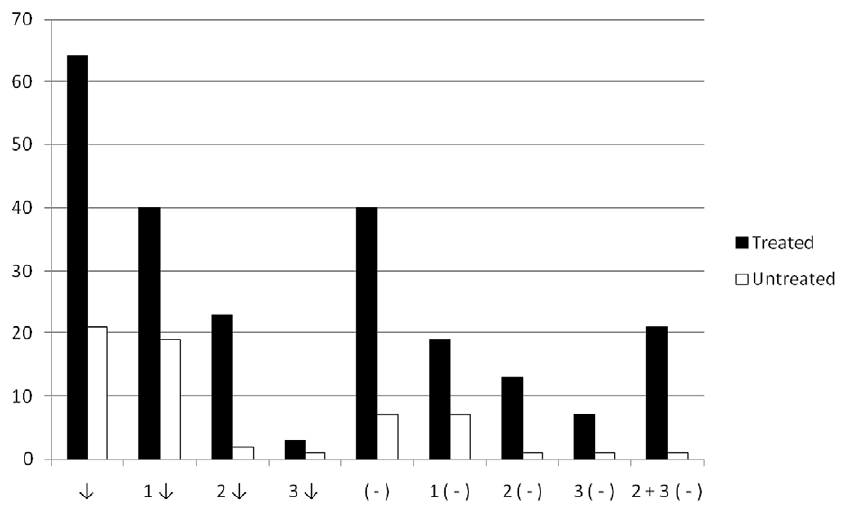
Figure 1. Percentages of titers decrease and seronegative conversion in treated and untreated chronically T. cruzi -infected subjects (a) . (a) The latest available serological data at the end of the study was considered for analysis. Q =decrease of titers on at least 1 test; 1 Q = titer decrease on 1 test; 2 Q = titer decrease on 2 tests; 3 Q = titer decrease on 3 tests; ( 2 ) = seronegative conversion on at least 1 test; 1 ( 2 ) = seronegative conversion on 1 test; 2 ( 2 ) = seronegative conversion on 2 tests; 3 ( 2 ) = seronegative conversion on 3 tests; 2 + 3 ( 2 ) = seronegative conversion on 2 or 3 tests.